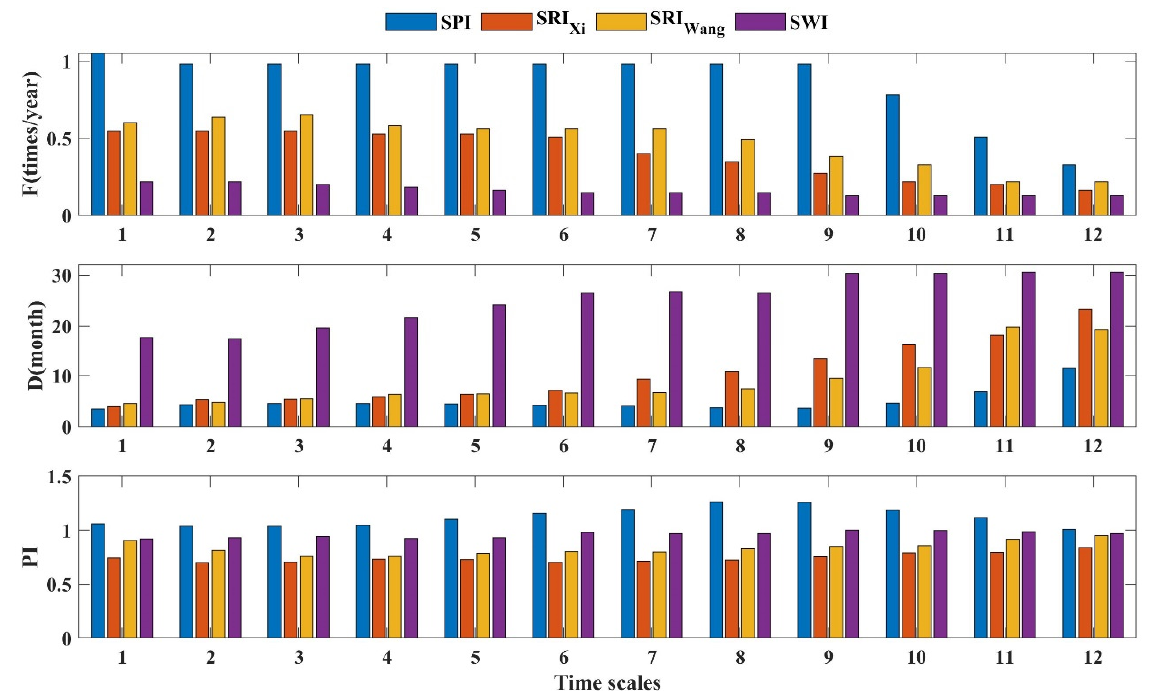
Figure 5. Drought characteristics of the SPI, SRI Xi , SRI Wang , and SWI at different timescales (PI denotes the absolute values).